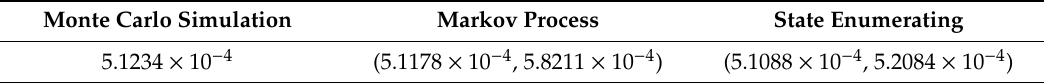
Table 2. Probability of the unsafe condition calculated by di ff erent methods.